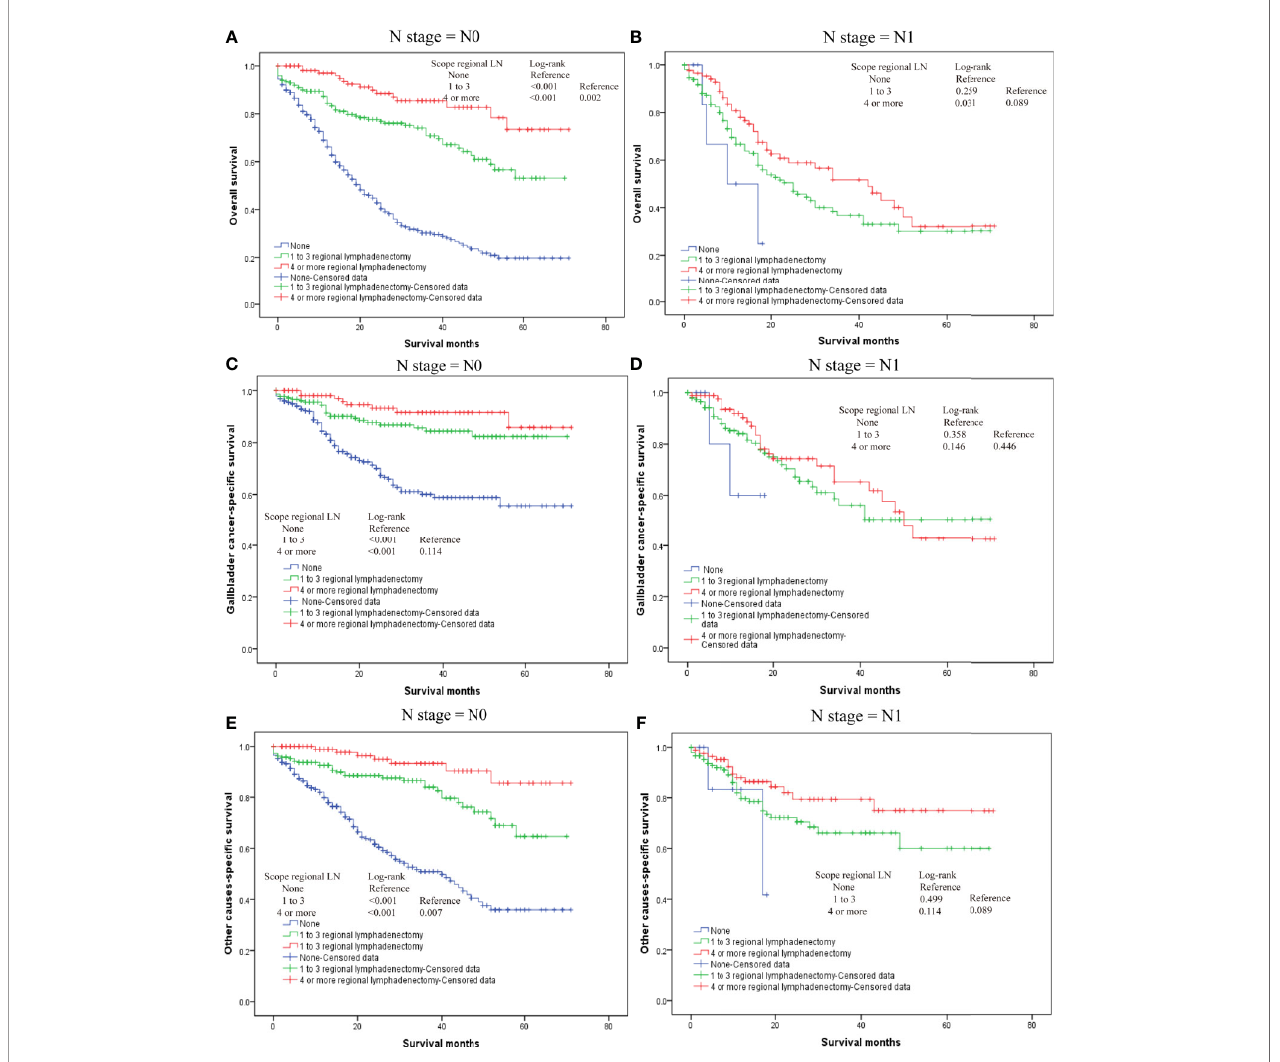
FIGURE 4 | The overall survival for T2 gallbladder cancer in different N-stages who underwent regional lymphadenectomy. (A) Kaplan – Meier plots for overall survival in the N0 stage. (B) Kaplan – Meier plots for overall survival in N1 stage. (C) Kaplan – Meier plots for cumulative gallbladder cancer-speci fi c survival in N0 stage. (D) Kaplan – Meier plots for cumulative gallbladder cause-speci fi c survival in N1 stage. (E) Kaplan – Meier plots for cumulative other cause-speci fi c survival in N0 stage. (F) Kaplan – Meier plots for cumulative other cause-speci fi c survival in N1